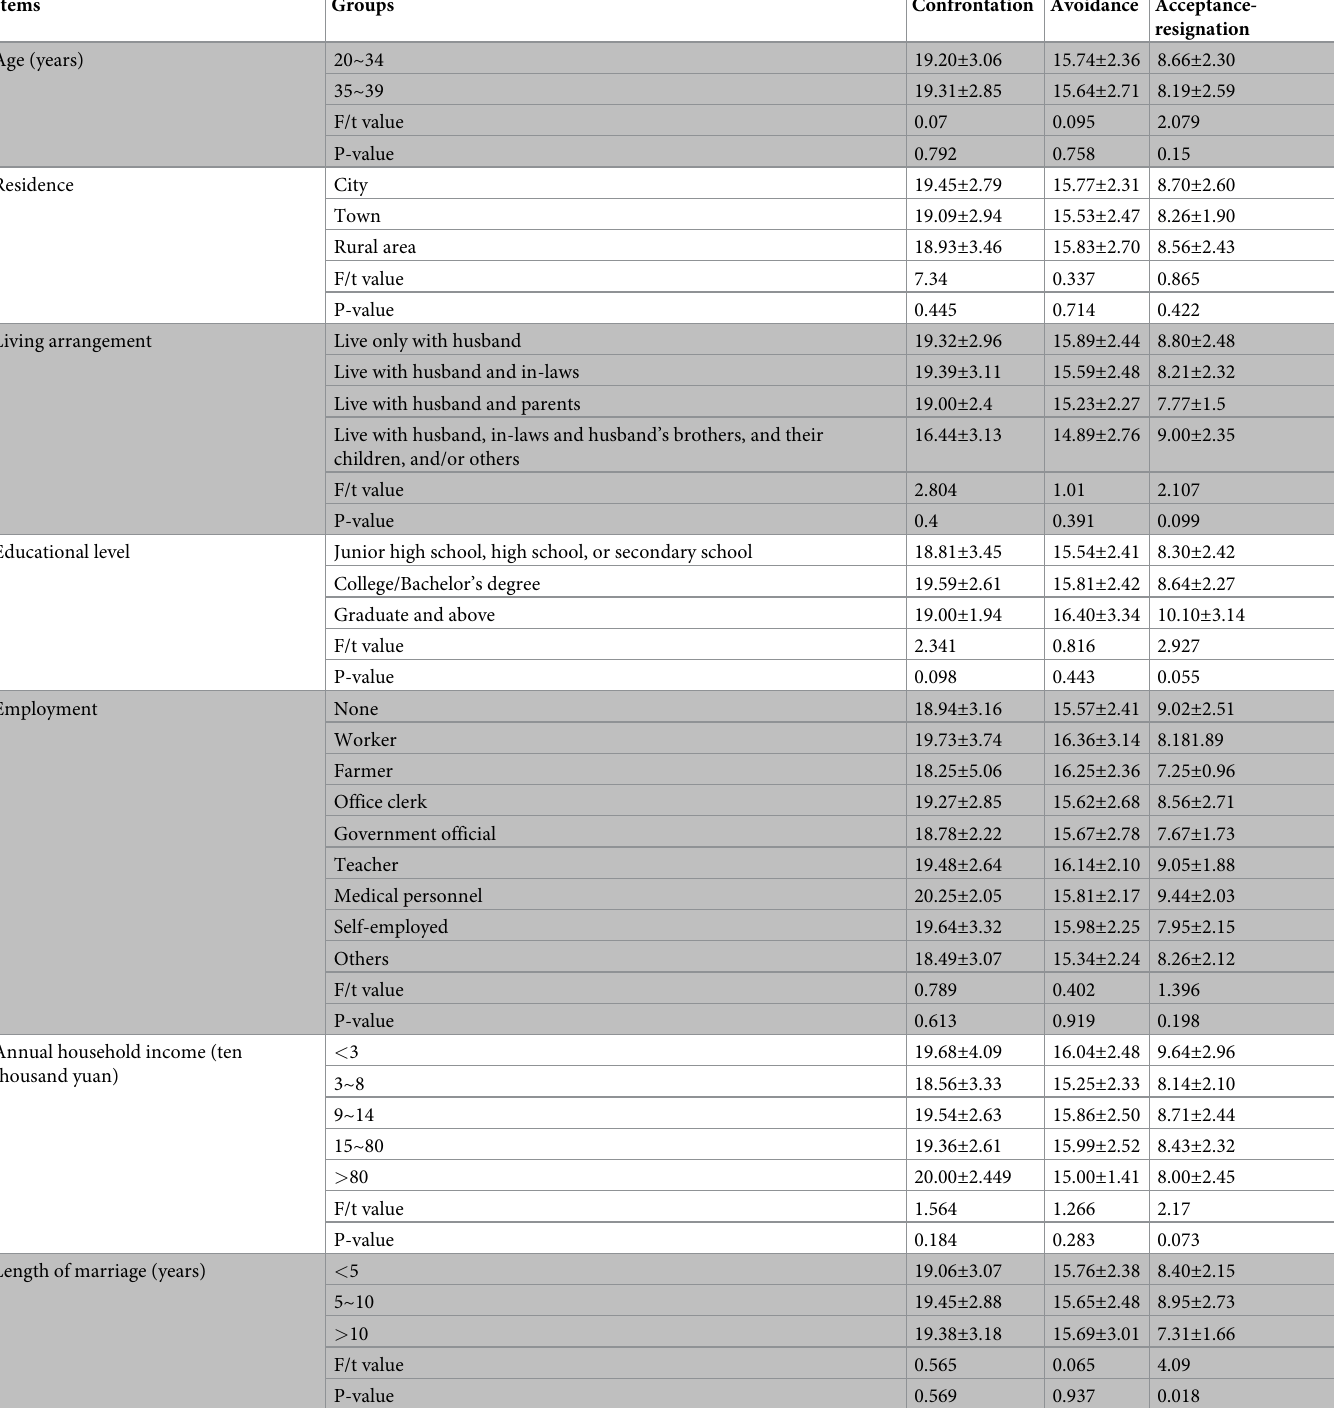
Table 3. Medical coping modes and demographic and clinical characteristics of patients treated with IVF-ET.